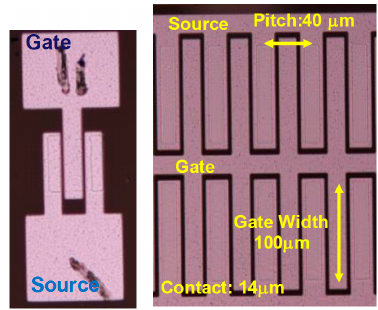
Figure 9. Plane view of the fabricated GaN DMOSFET with an L g of 0.4 µ m and W g of 50 µ m. The cell pitch of the power DMOSFET was 40 µ m.